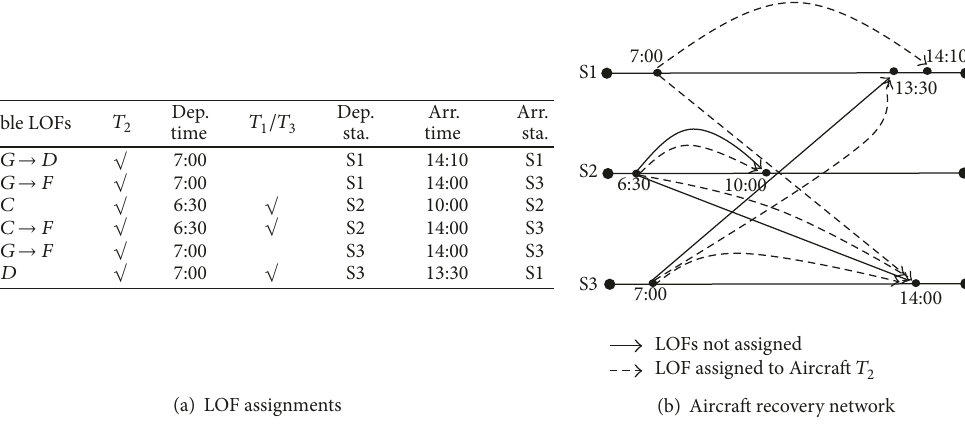
Figure 6: Aggregated aircraft recovery network: (a) LOF assignment and (b) aggregated aircraft recovery network.